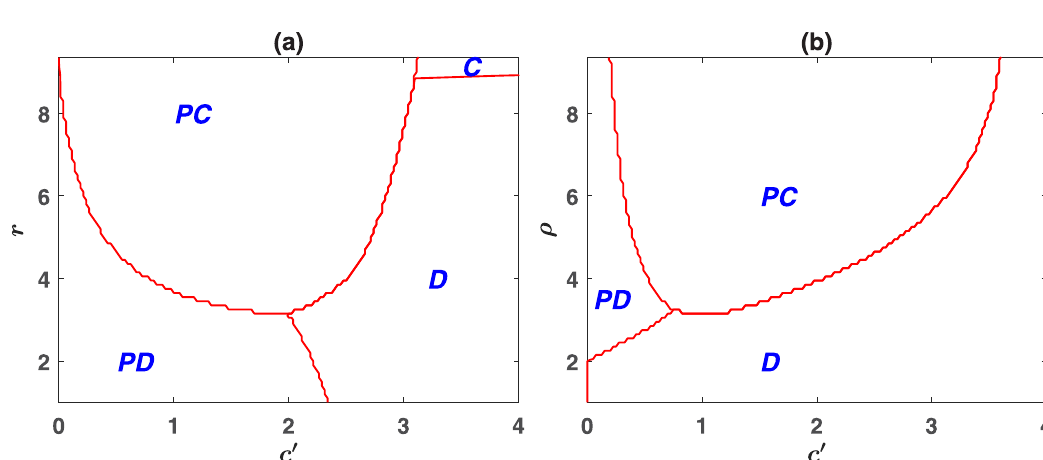
Fig 2. Dependence on the cost of investment in punishment pool, c 0 . The phase diagram of the wasteful punishment model in r − c 0 (a) and ρ − c 0 planes (b). For too small c 0 antisocial punishment evolves, and for too large c 0 non-punishing defectors survive. For medium values of c 0 prosocial punishment evolves. An optimal c 0 , which is comparable to c = 1, facilitates the evolution of prosocial punishment. Parameter values: g = 9, ν = 10 − 3 , α = 0.5, and c = 1. In (a) ρ = 5 and in (b) r = 5. The replicator dynamics is used to derive the phase diagrams.